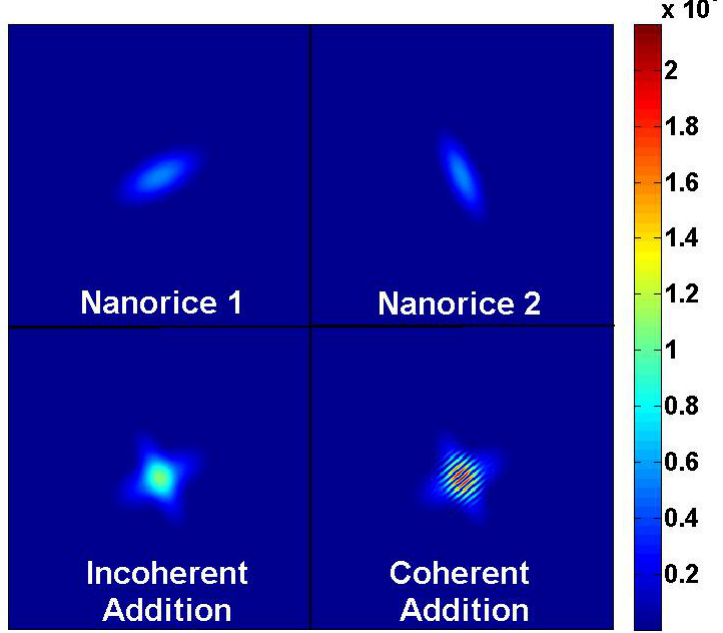
Figure 2. Simulated X-ray free electron laser (XFEL) diffraction patterns of one and two nanorice particles in random